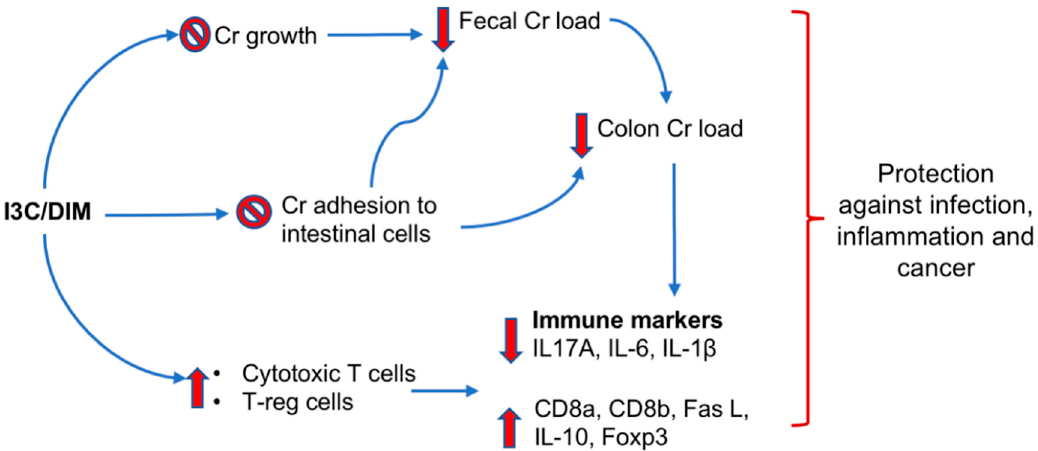
Figure 8. Working model for protective effects of I3C/DIM on infection, inflammation and cancer. I3C/DIM exert its protective effects through multiple mechanisms that include affecting bacterial growth, adhesion as well as immune responses mediated by AhR. Overall, the effects lead to decreased inflammation and protection against cancer.